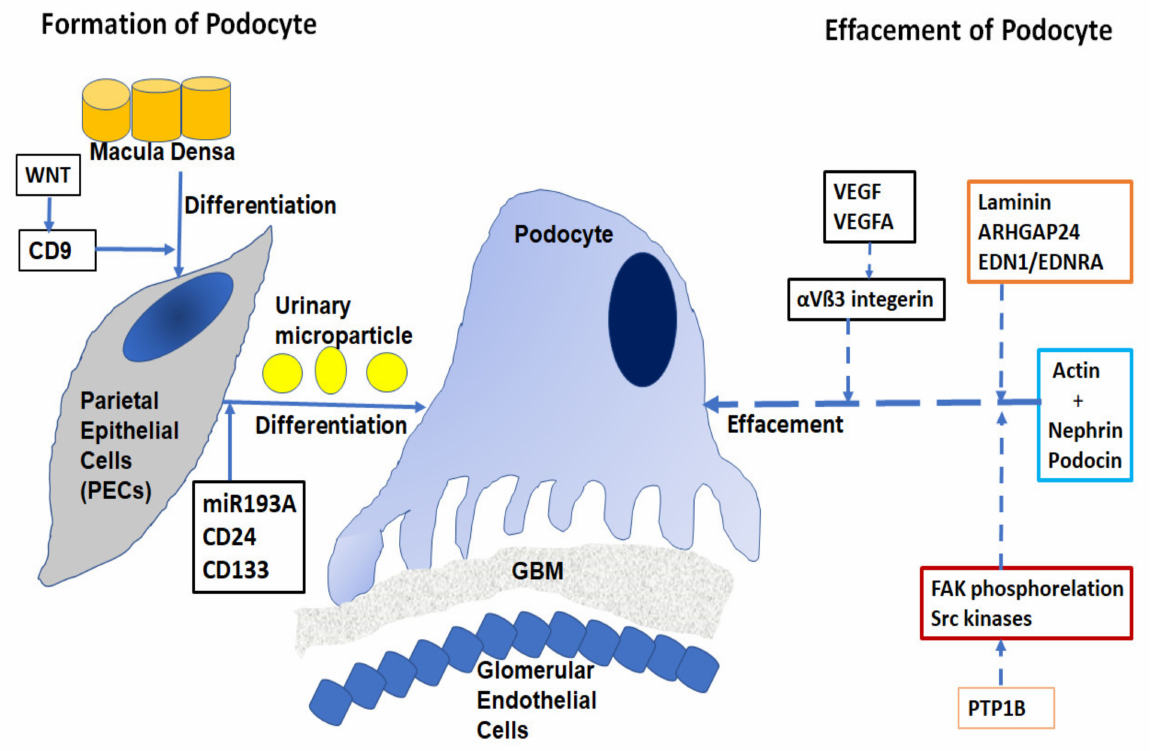
Figure 1. Podocyte–glomerular junction. GBM—Glomerular Basement Membrane. The macula densa differentiates into Parietal Epithelial Cells (PECs) using CD9, which is activated by WNT signaling genes/proteins. PECs differentiate into podocytes. miR193a plays a critical role in this process, whereas podocyte effacement is a complex procedure involving a series of proteins/genes, mainly with actin reorganization activated by a group of